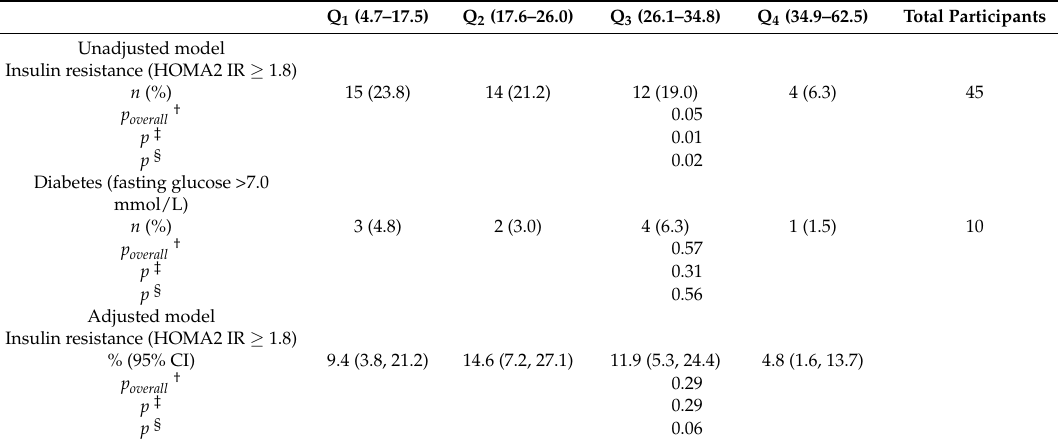
Table 4. Prevalence of insulin resistance and diabetes by 25-hydroxyvitamin D [ng/mL] quartiles (Q 1 –Q 4 )